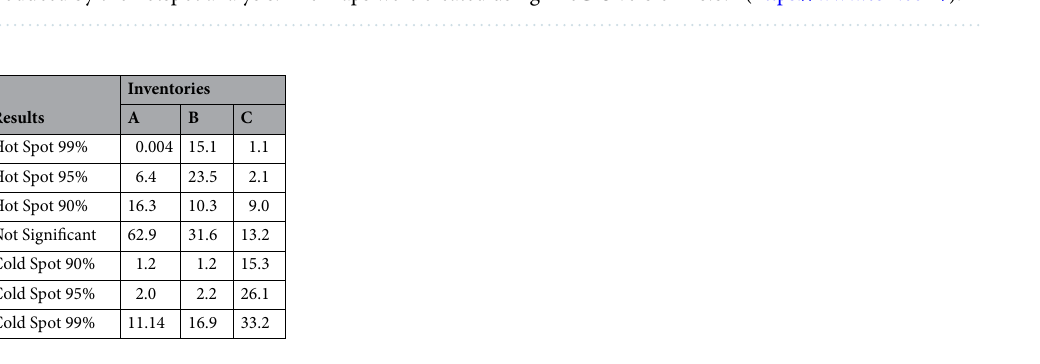
Figure 10. Hotspot analysis of LSMs for three inventories ( A – C ). Percentages represent confidence level, as produced by the hotspot analysis. The maps were created using ArcGIS version 10.8.1 (https:// www. esri. com/).